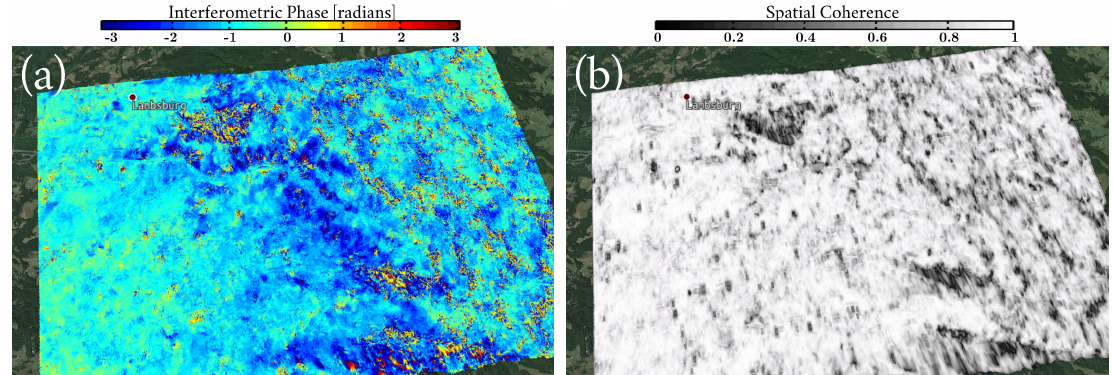
Figure 11. Example of ALOS-1 interferogram and the corresponding coherence map. The master date is 2011/02/15 and the slave date is 2010/12/31. The normal baseline is 675 meters. ( a ): the interferogram; ( b ): the coherence